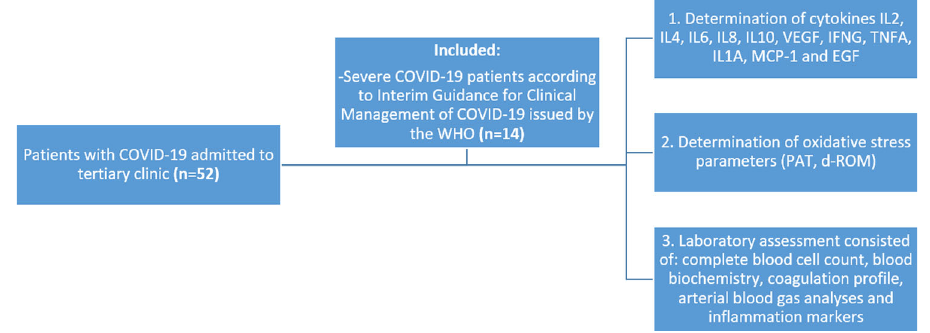
Figure 1. Flow-chart of the